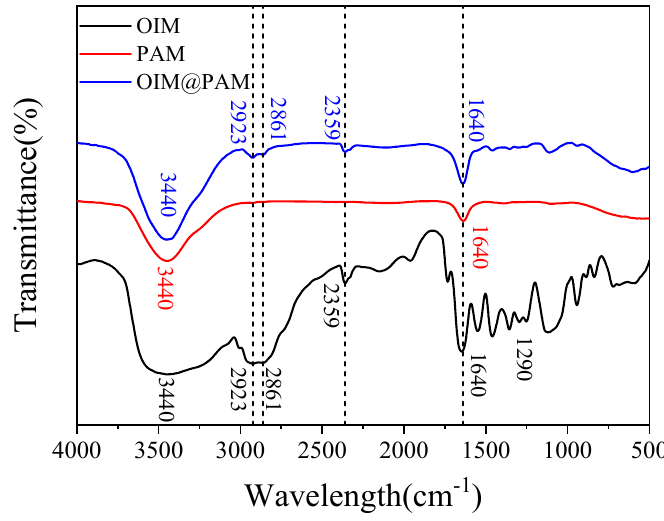
Figure 2. FTIR spectra of pure OIM , PAM and OIM@PAM.